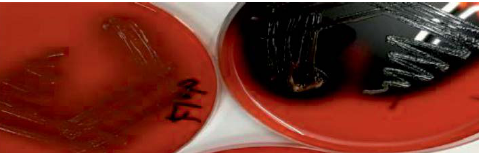
Fig. 3. Biofilm formation by A -Congo red agar B- modified Congo red